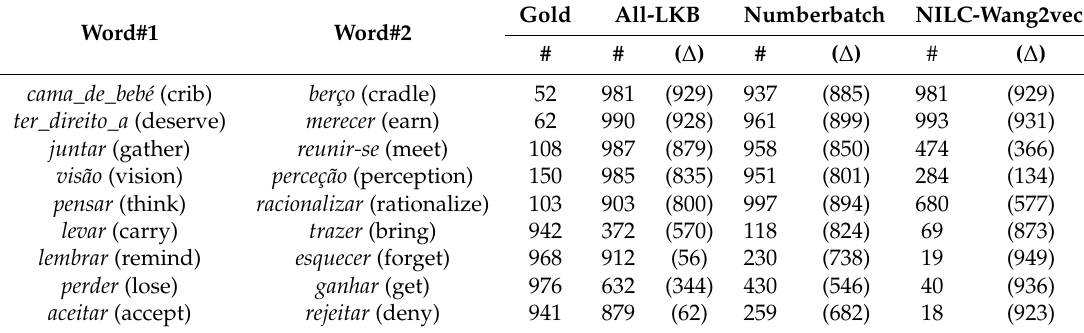
Table 14. Word pairs with higher rank difference ( ∆ ) in procedures using three different databases and gold score in SimLex-999.